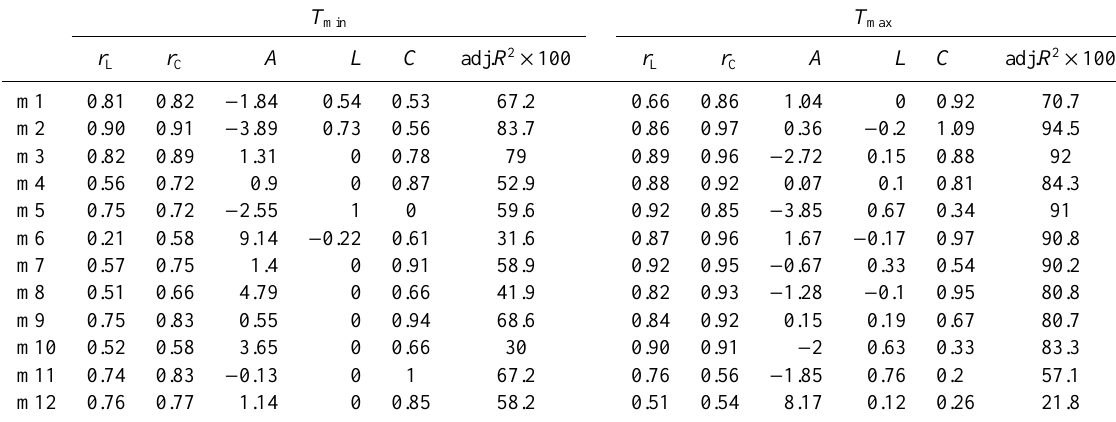
Changes in the measurement times no Table 4. Correlation coe ffi cients between the temperature series from Porto and Lisbon ( r L ) and Coimbra ( r C ) calculated for the period 1910–1932 ( ± 10yr around the gap). Significances of the correlation coe ffi cients ( p ) are smaller than 0.02 with only one exception: p = 0 . 37 for correlation coe ffi cients between T min of Porto and Lisbon in June (m6). Regression coe ffi cients ( A , L , C ) for regression models (Porto and calculated using data for the period 1910–1932 ( ± 10yr around the gap). (adj. R 2 × 100) values show the percent of the variability of the dependent variables (Porto T min and T max series) that has been accounted for by the model under